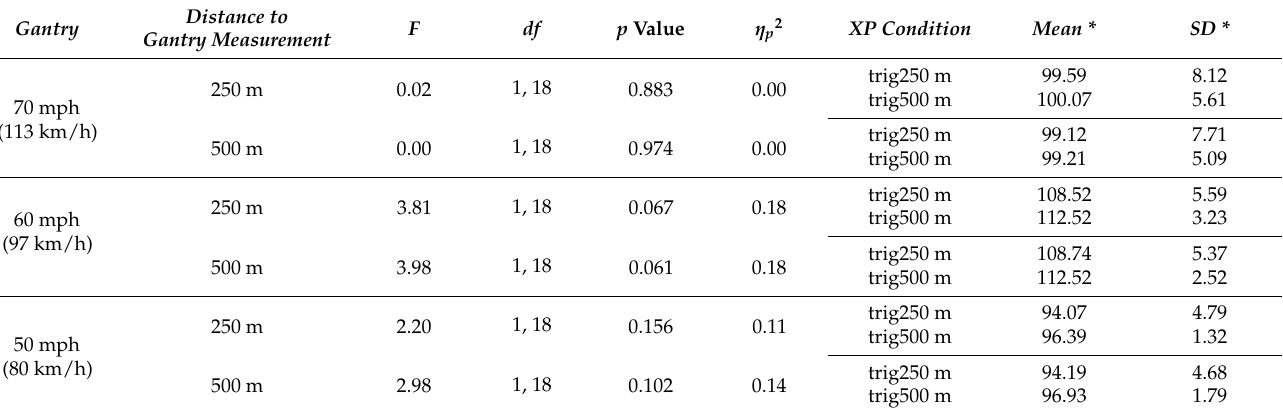
Table 3. Analysis of variance to test the mean speed of both experimental groups in the baseline noHMI